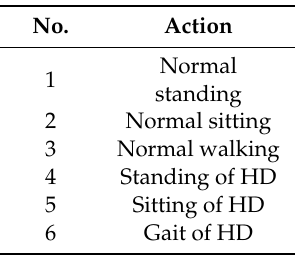
Table 1. The actions used in the